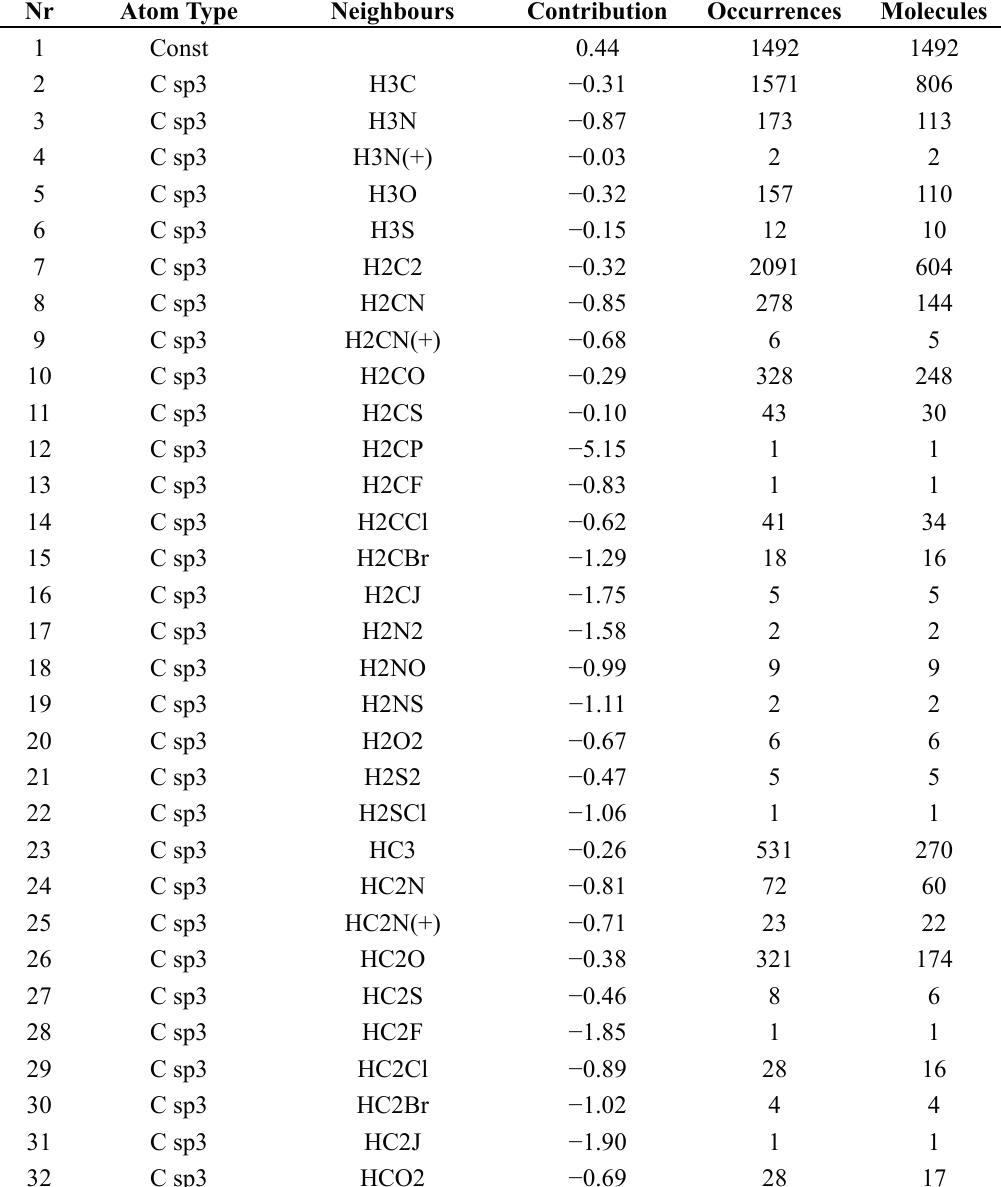
Table 11. Atom group Contributions for LogS